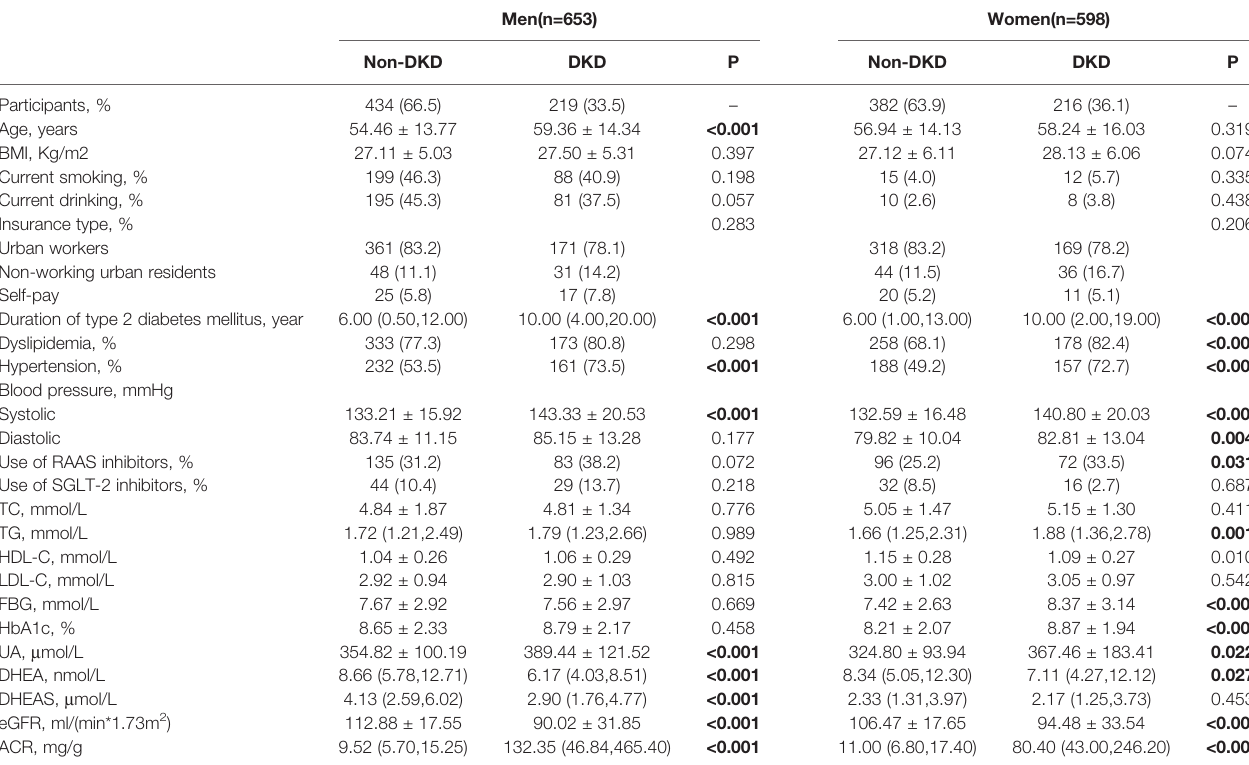
TABLE 1 | Characteristics of patients with and without